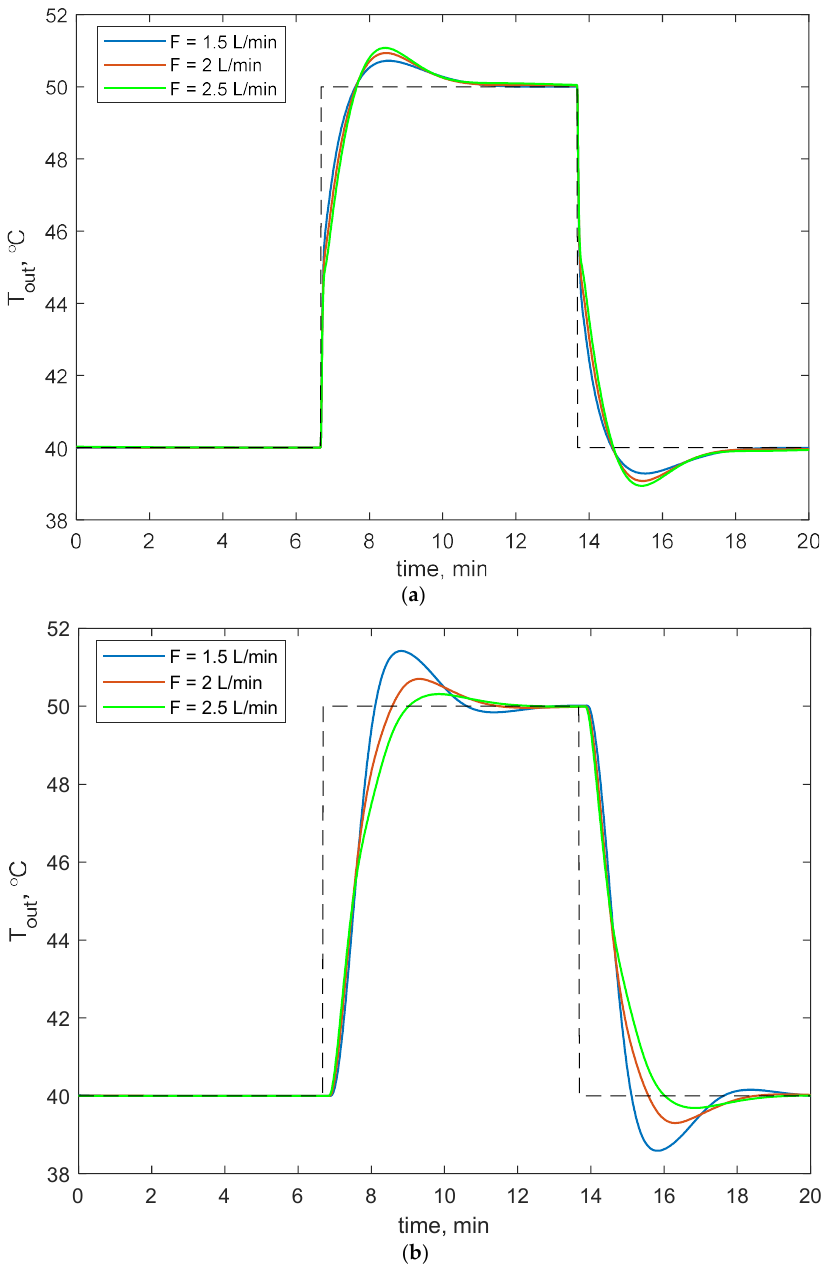
Figure 9. The robustness of both considered HCS structures. Both figures show the tracking per- formance of the proposed habituating HCS ( a ) and a single ADRC structure ( b ), for different flow rates F .